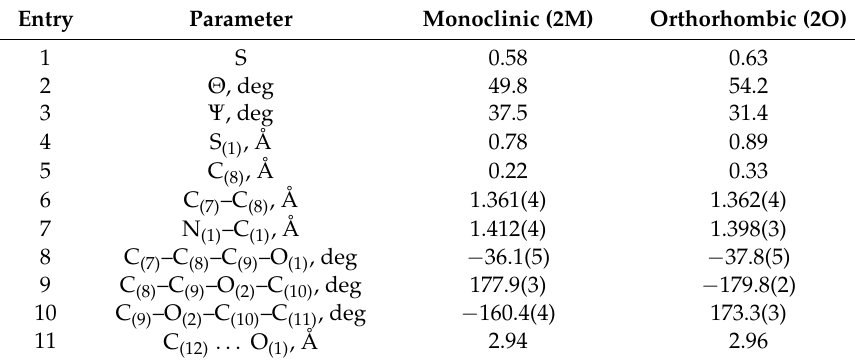
Table 1. Some geometric characteristics of the polymorphic form ester 2